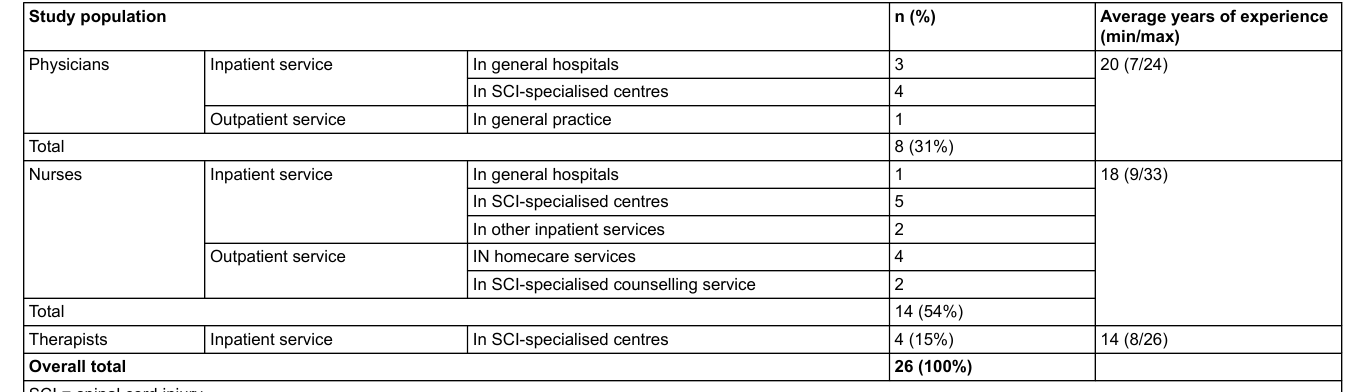
Table 2: Population